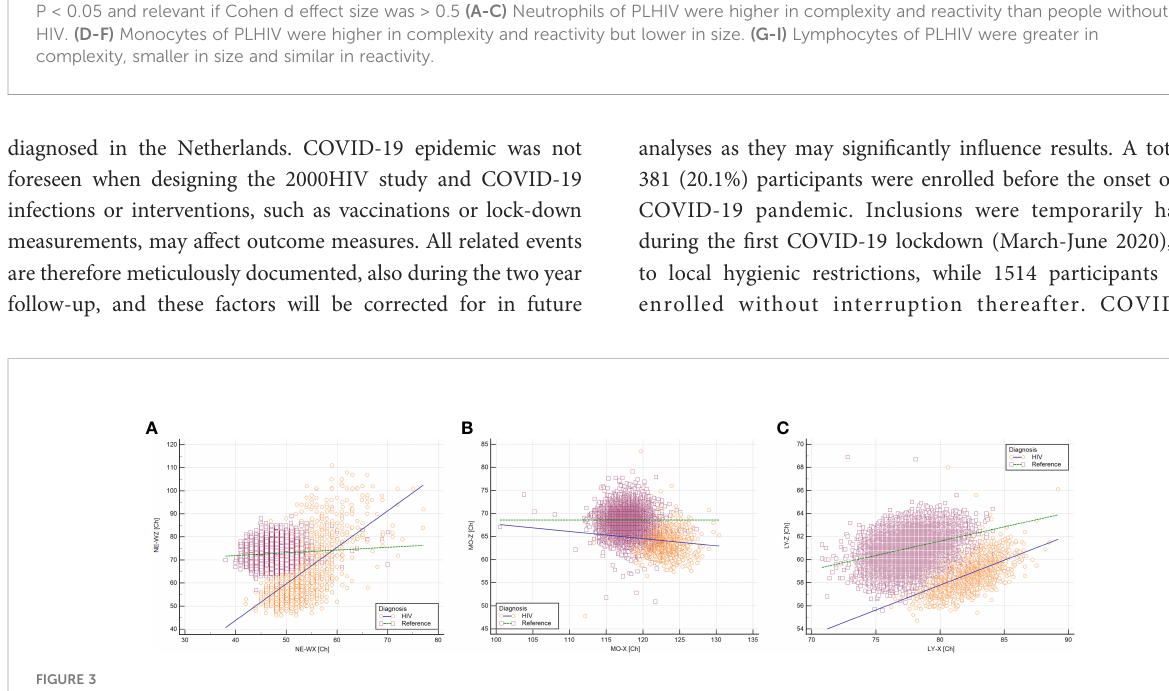
FIGURE 2 Neutrophils and monocytes of PLHIV have increased complexity and reactivity compared with people without HIV in Sysmex hemocytometry. N = 1895 PLHIV with suppressed viral loads were compared to N = 15,803 people without HIV. To place treated HIV in a context, PLHIV were displayed next to acute infectious disease cohorts. These other cohorts consisted of patients presenting with acute febrile disease at the ER who subsequently underwent extensive diagnostic testing. Cohen ’ s d is a measure of the effect size. Differences were considered signi fi cant if